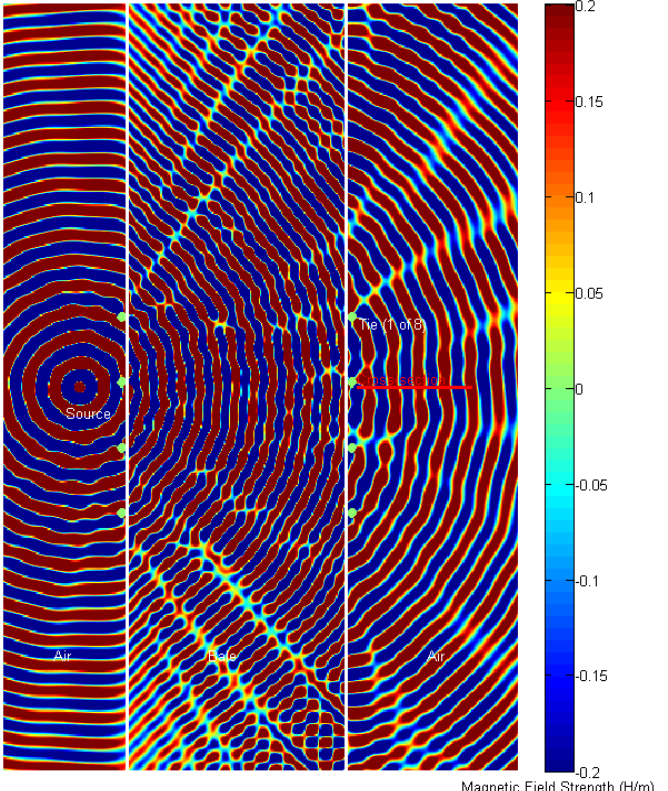
Figure 8. FDTD simulation prediction showing constructive-destructive interference as the advancing wave-fronts propagates from left to right, magnetic field strength, “H/m”, with the top view showing the 2.5 GHz simulation and the 2.0 GHz simulation in the bottom view. Of particular interest are the ripples or delays in the advancing front that are to the right and downstream from the metal bale-ties where the antennas would be located which would translate to an additional delay in the measured phase due to the ripples created by the Mie scattering.